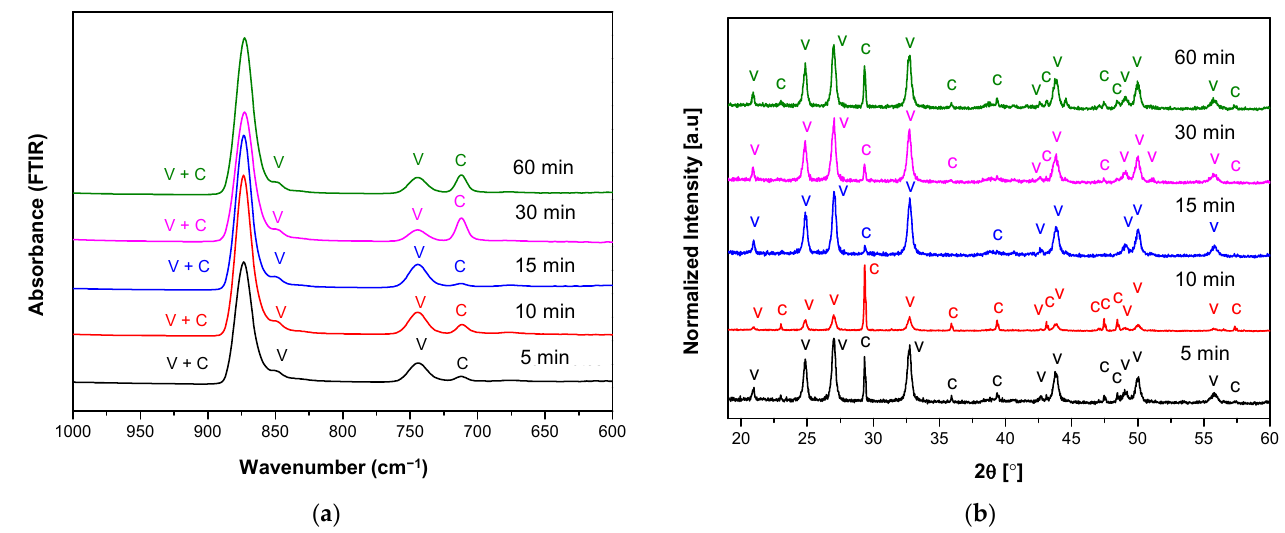
Figure 2. ( a ) FTIR and ( b ) XRD spectra of vaterite synthesized at 20 °C for different reaction times (5–60 min) at stirring speed 800 rpm. Polymorphs main peak is indicated (V = vaterite, C = calcite).